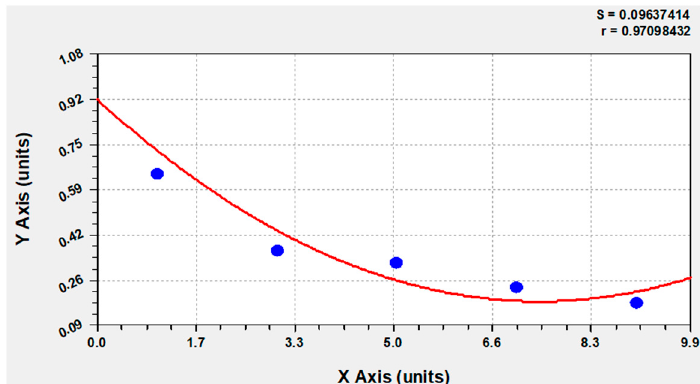
Figure 6. The computer-based calculation showed at the outset of the investigation 92% that Calbindin D28k positive glial cells are also GFAP-positive. The blue circle: the percentage of GFAP positive cells from day 1 to day 9 in the medium with 10% FBS gradually decreased from 64.69% to − 36.54% to − 32.07% to − 23.38% and finally to − 17.47% of the total number of Calbindin D28k positive glial cells. The red line: adjustment of the data with Curve expert 1.4.